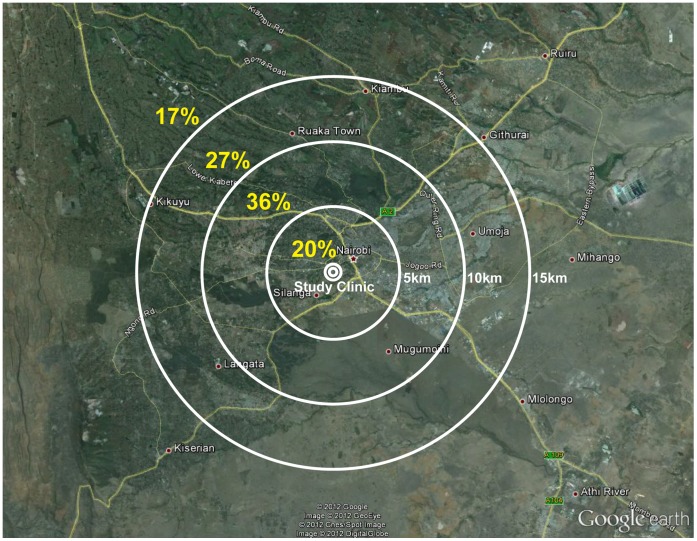
Map of distances from the study clinic.The map of Nairobi shows the location of the study clinic, with linear distances to the study clinic indicated by concentric white circles at 5 km increments. The percentage of participants living within each section is shown in yellow.